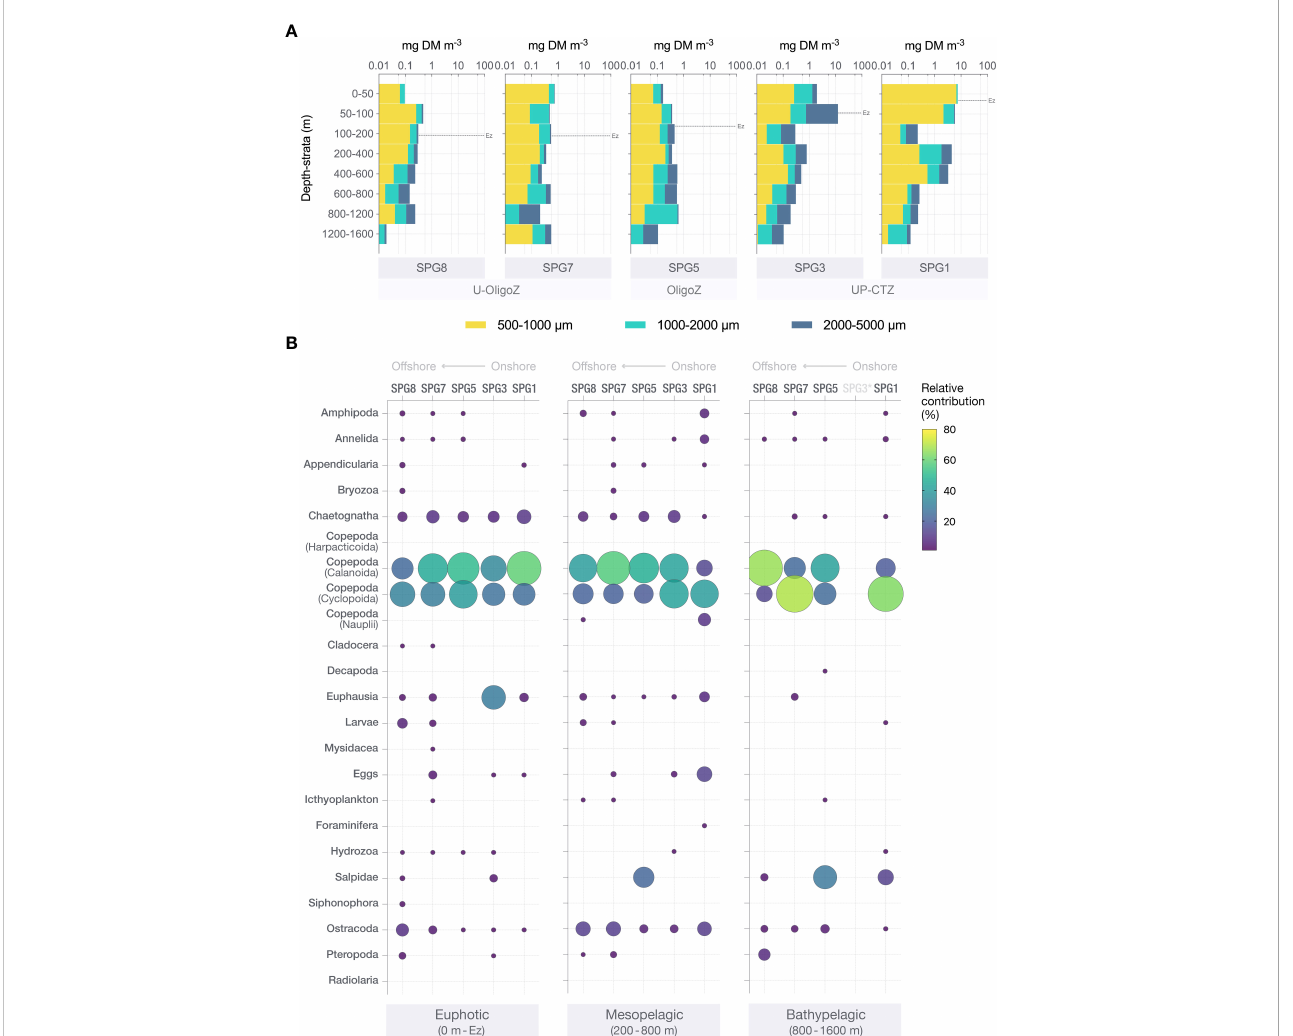
FIGURE 3 (A) Vertical pro fi les of the logarithm of zooplankton dry mass (DM) for those stations sampled for CSIA-AA along the productivity gradient in the Southeast Paci fi c. The horizontal black dashed line stands for the euphotic zone (Ez) at each station. (B) Relative contribution (in percentage) of each zooplankton group to the total community abundance in the euphotic, mesopelagic and bathypelagic zones from the 5 stations where the CSIA-AA analyses were performed. Circle size is proportional to the corresponding percentage, also represented by the color bar. No circles means no presence, except for the bathypelagic layer of SPG3 (marked with an asterisk), where no sample for taxonomy was